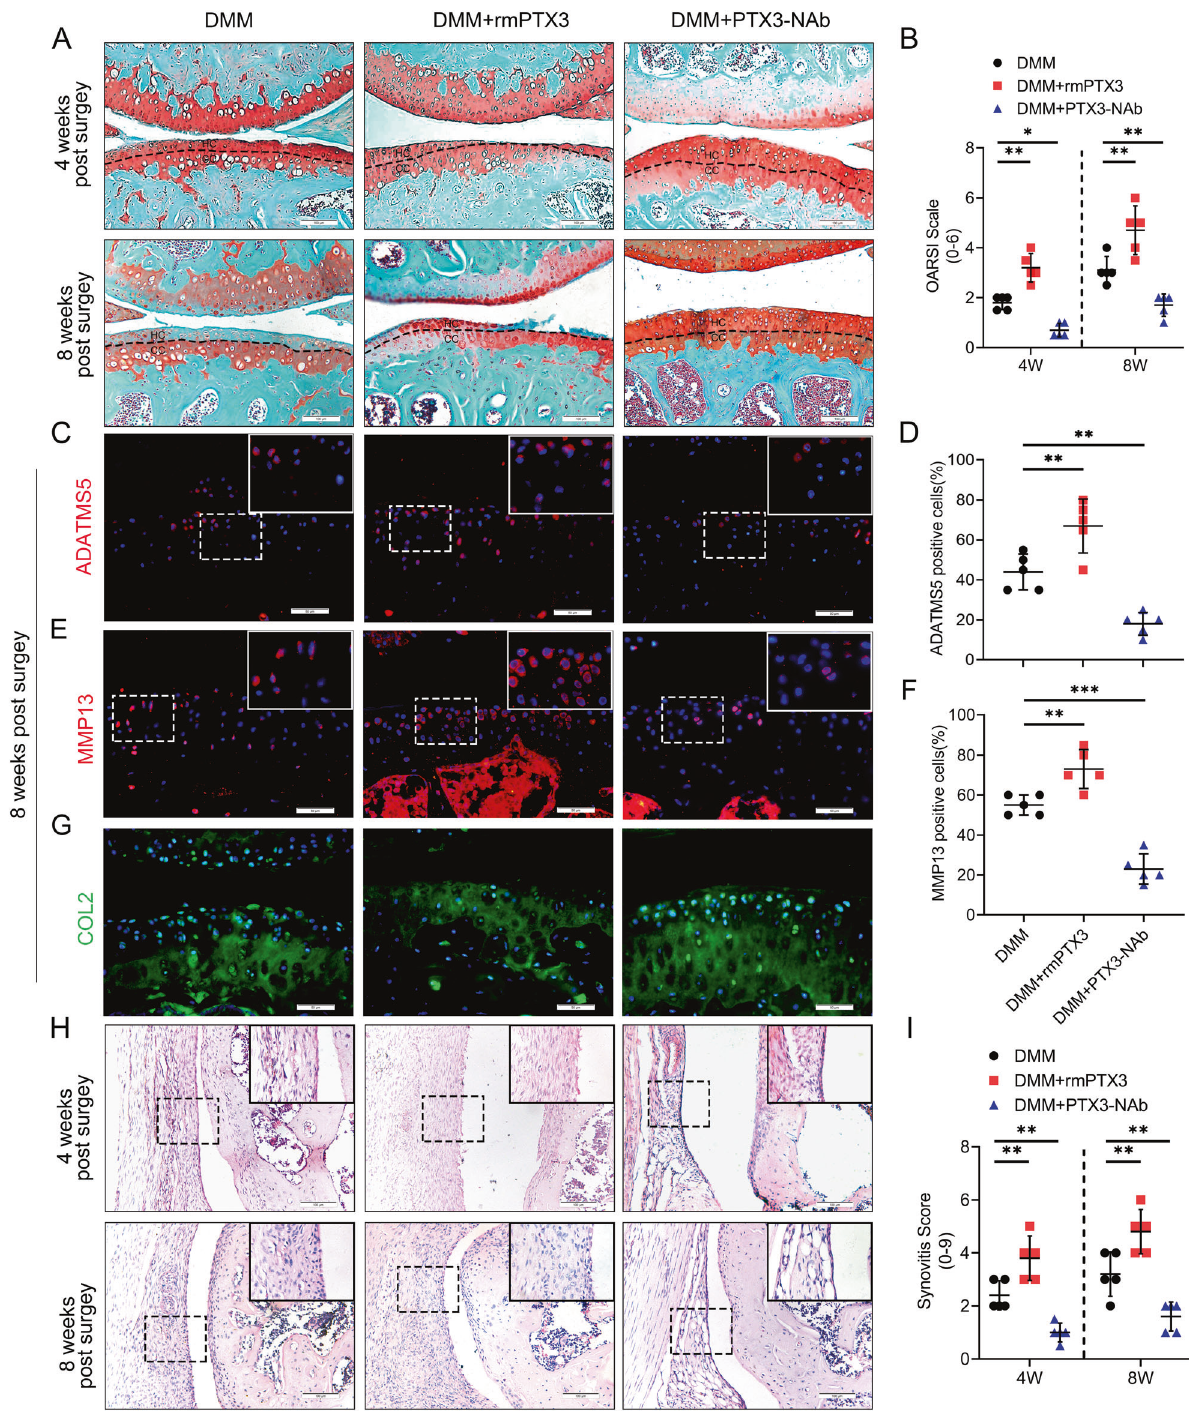
Fig. 2 PTX3 accelerates synovitis, cartilage erosion, and exacerbates OA development in mice. A , B Safranin O/fast green staining and Osteoarthritis Research Society International (OARSI) grades of knee cartilage from DMM mice treated with vehicle, recombinant mouse PTX3 (rmPTX3), or PTX3 neutralizing antibody (PTX3-NAb) for 4 weeks and 8 weeks. Scale bar: 100 µm. C – F IF staining and quanti fi cation of ADATMS5 and MMP13 in knee cartilage of controls and DMM mice treated with vehicle, rmPTX3, or PTX3-NAb for 8 weeks. Scale bar: 50 µm. G IF staining and quanti fi cation of COL2 in knee cartilage of controls and DMM mice treated with rmPTX3 or PTX3-NAb for 8 weeks. Scale bar: 50 µm. H , I H&E and synovitis score of synovial tissues from DMM mice treated with vehicle, rmPTX3, or PTX3-NAb for 4 weeks and 8 weeks. Scale bar: 100 µm. * P < 0.05, ** P < 0.01, *** P < 0.001, ns not signi fi cant. Data are shown as means ± SD. Statistical analyses were conducted by two-way analysis of variance followed by Sidak ’ s multiple comparison test ( B and I ) or one-way analysis of variance followed by Dunnett ’ s multiple comparison test ( D and F ). Boxed area is enlarged in the top right corner.